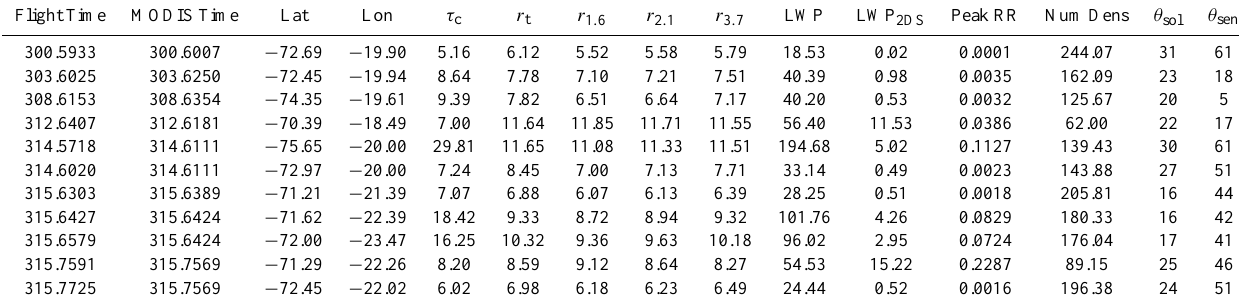
Table 1. Summary of profiles used. Flight Time